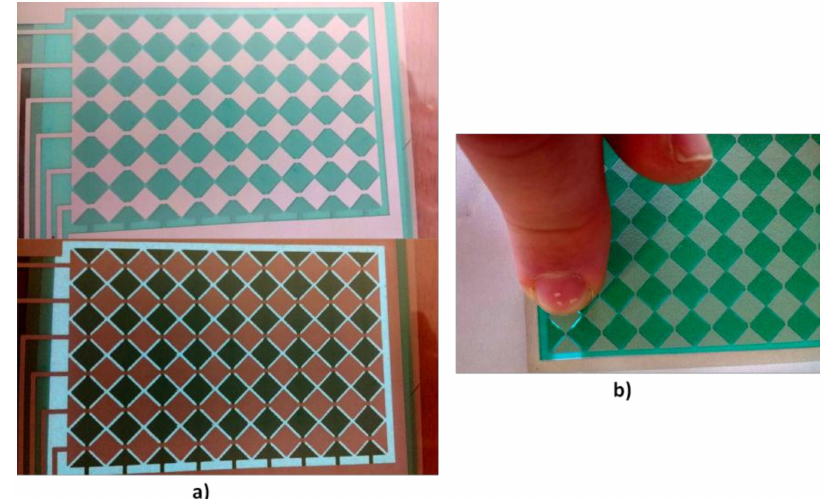
Figure 9. 2D touchpad with ELD on and off ( a ). Redesign in order to turn on only the zone that has been touched ( b ). The design has been manufactured with